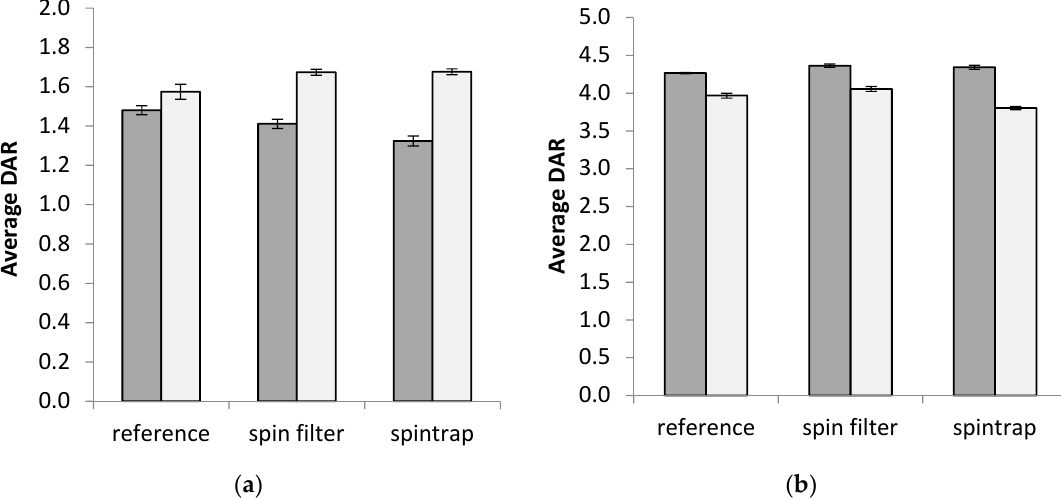
Figure 3. Average apparent DAR-values of ADCs depending on desalting method. Depending on the desalting method, the average DAR showed different behavior in relation to if the desalting was done on intact or free light and heavy chains for the two investigated ADCs ( a ) vcMMAE–trastuzumab and ( b ) DM1–trastuzumab. Gray bars—desalting prior reduction, White bars—desalting after reduction. As desalting prior to or after the reduction step was prepared on two different dates, a fresh reference without offline desalting was made for each sample set. Spintrap (GE PD spintrap gel–filtration columns) and spin filter (Amicon Ultra 3 kDa, after or 30 kDa, before, MWCO) were prepared in duplicates and reported values are combined values of triplicate injections over both replicates. Error bars depict the standard deviation from triplicate measurements for each sample (for two samples combined for the two desalting options).